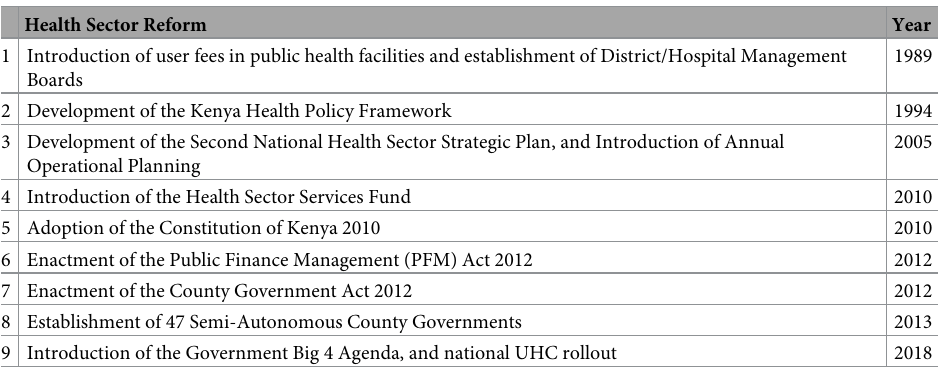
Table 1. Summary of key sub-national health sector governance reforms in Kenya. Health Sector